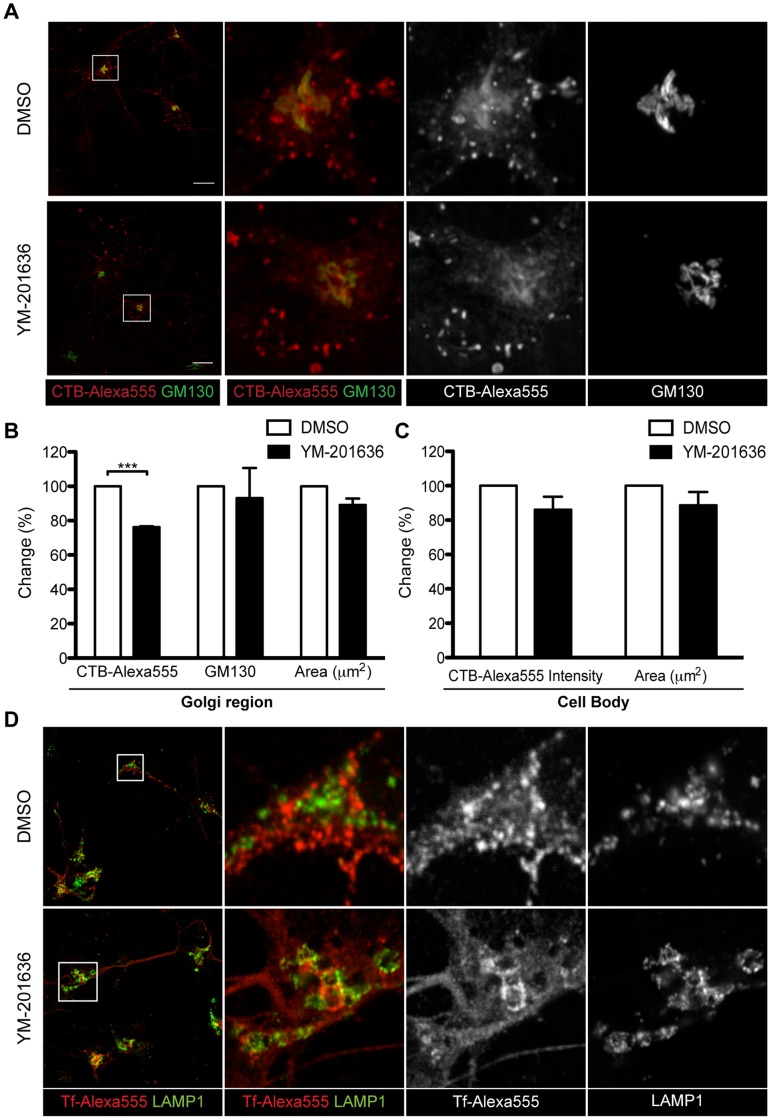
The effect of YM-201636 on endosomal and retrograde trafficking in hippocampal neurons.(A) Primary hippocampal neurons were treated with DMSO or 1 µM YM-201636 for 2 h then supplemented with 1 µg/ml CTB-Alexa555 for a further 2 h. Cells were fixed and immunolabelled for GM130. Representative 3D projections are shown. (B) The integrated intensity (per µm2) of CTB-Alexa555 in Golgi complex, as defined by GM130, the integrated intensity of GM130 and the size of the area analysed was measured and the percentage change between conditions determined. (C) The change in total CTB-Alexa555 integrated intensity within the cell body and the area (µm2) of the cell body was determined. (mean ± SEM, n = 3 independent experiments, 11–20 cells per experiment). Significances relative to DMSO *p<0.05, **p<0.01, ***p<0.001 (D) Primary hippocampal neurons were treated with DMSO or 1 µM YM-201636 for 3.5 h then supplemented with 25 µg/ml transferrin-Alexa555 (Tf-Alexa555) for a further 30 min. Cells were fixed and immunolabelled for LAMP1. Scale bar = 10 µm.